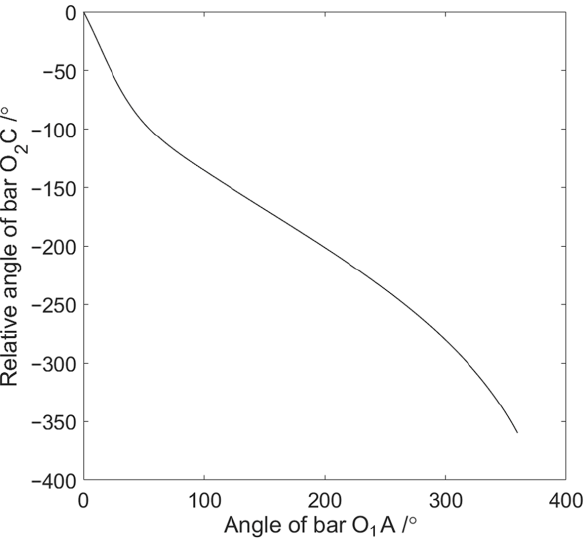
Figure 12. The relation curve of two crank rotation angles in one cycle.